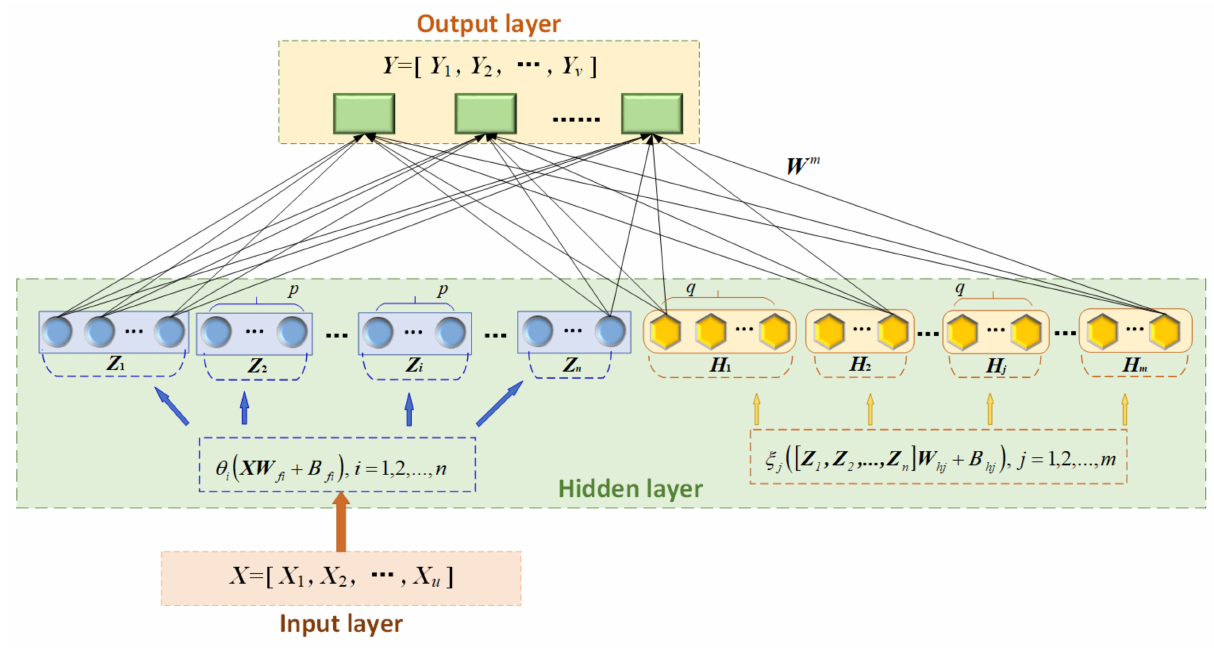
Figure 2. Structure of